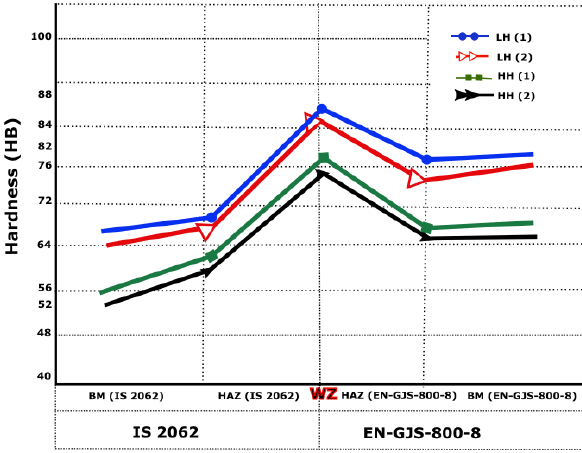
Figure 13: Dissimilar weld of IS 2062/EN-GJS-800-8. Hardness analysis. Normal welding process, (1) Low heat input LH heat input HH . PWHT process. (2) Low Heat LH 1 HH .Reprinted with permission from Sergio et al. // Material 2